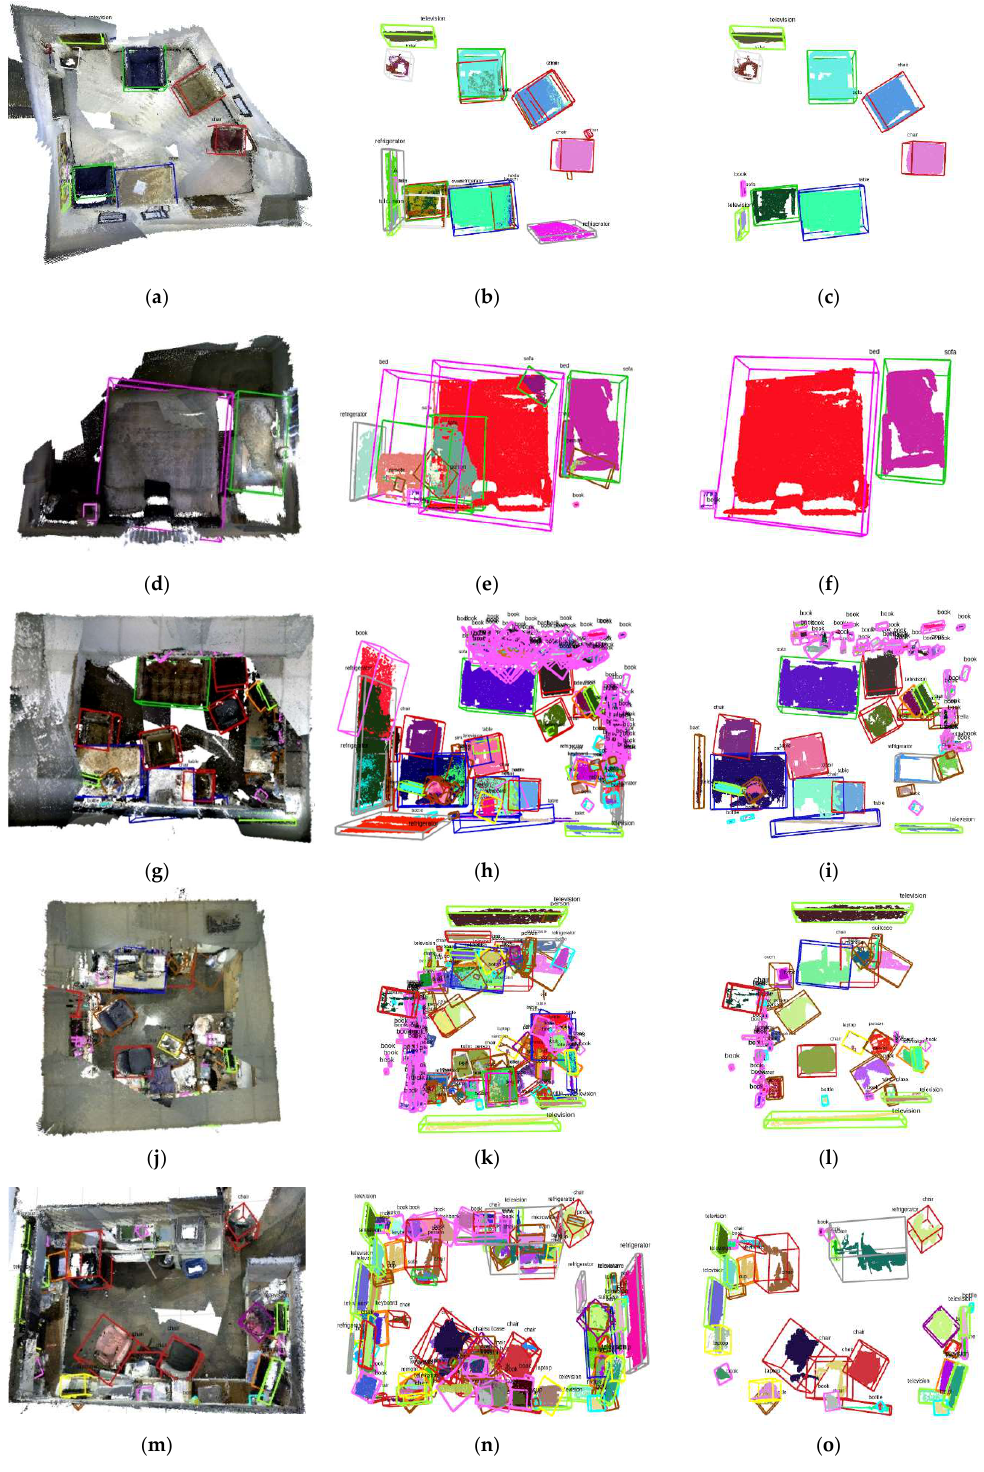
Figure 6. 3D object bounding box detection experiments on the SceneNN dataset (from top to down, sequence number: 011, 016, 030, 078, 086; the first column ( a , d , g , j , m ) is the final detection with point cloud map, the middle column ( b , e , h , k , n ) is the detection objects before database refinement, the final column ( c , f , i , l , o ) is the detection objects after database refinement).